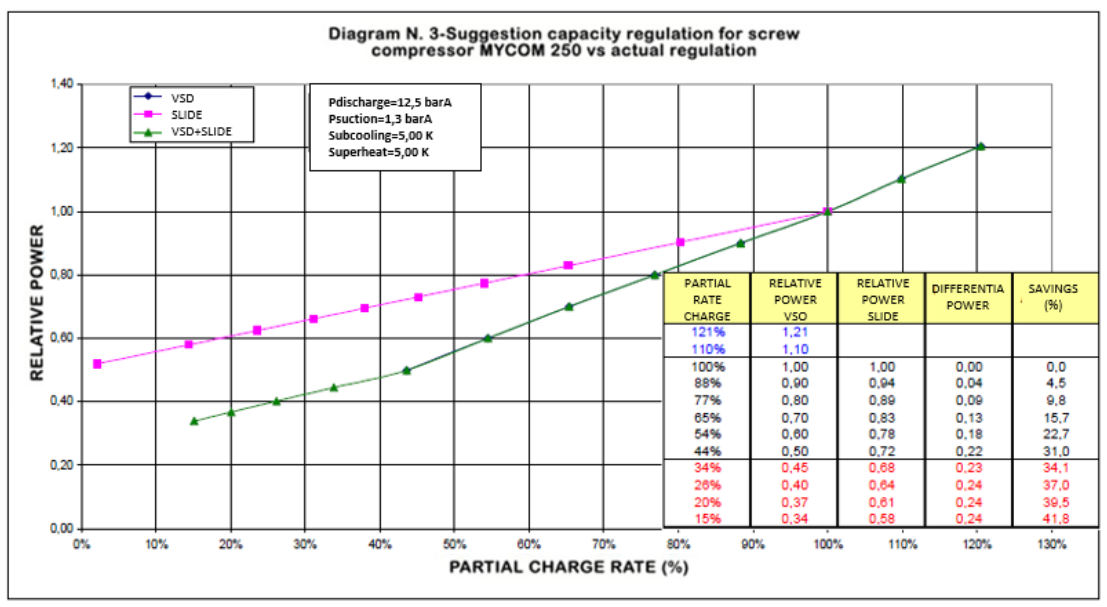
Figure 12. Integration graph of slide regulation with speed variation in compressor No. 6 and 9.